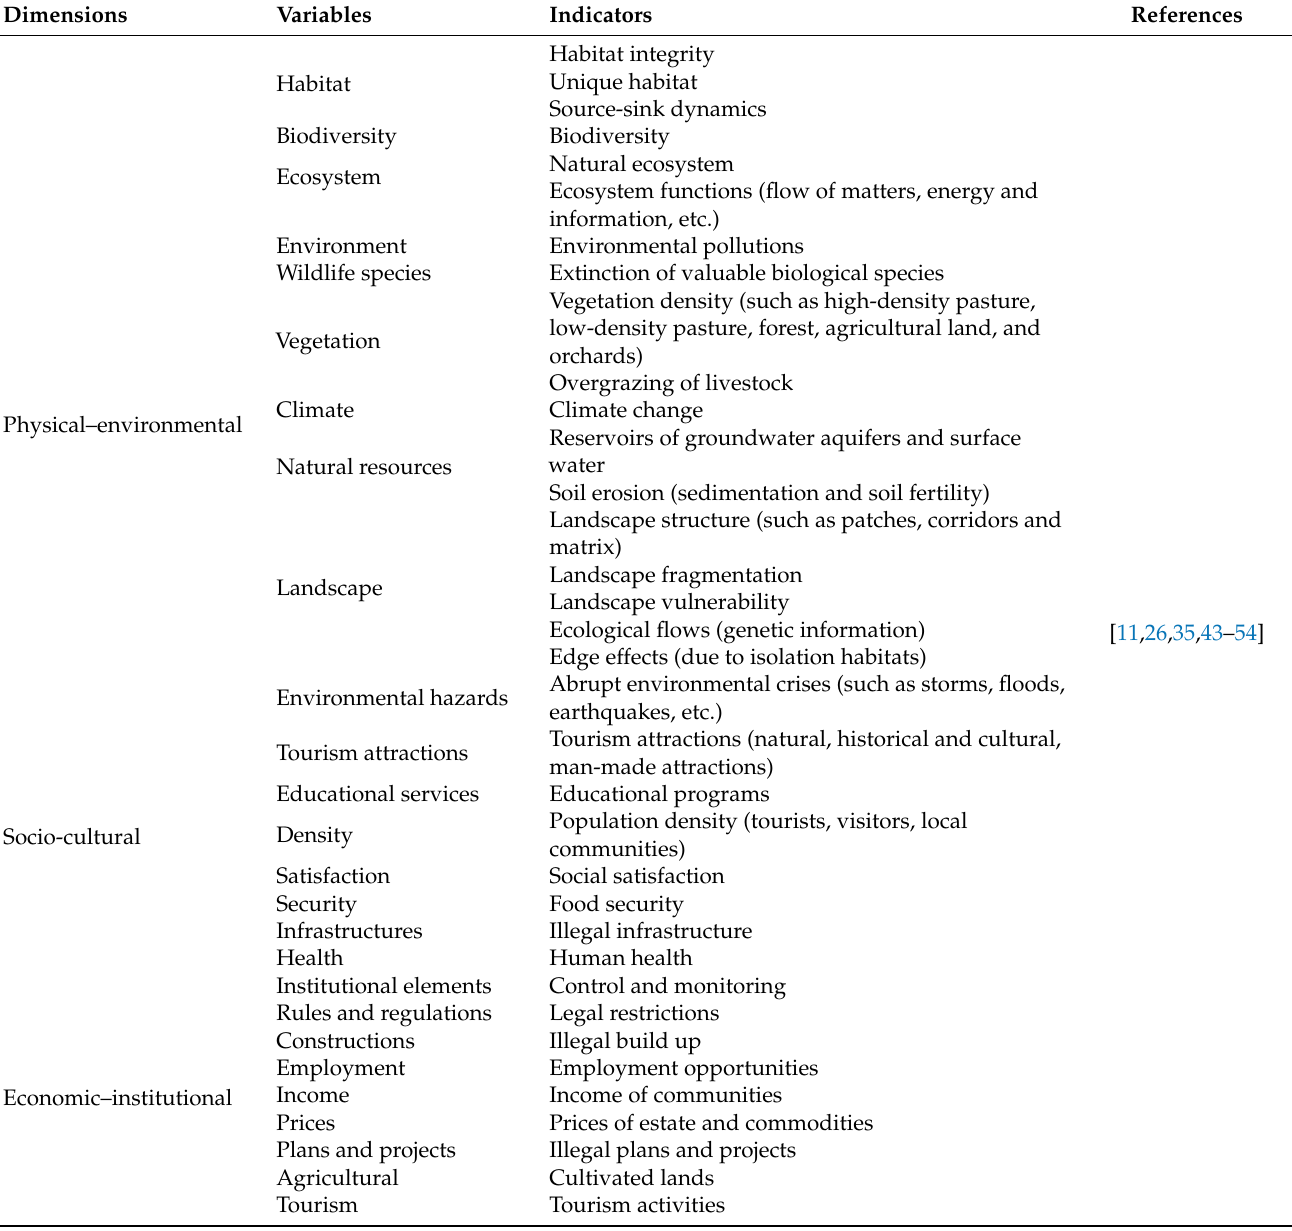
Table 1. List of dimensions, variables, and indicators affected by ecological risk (ER) in Protected